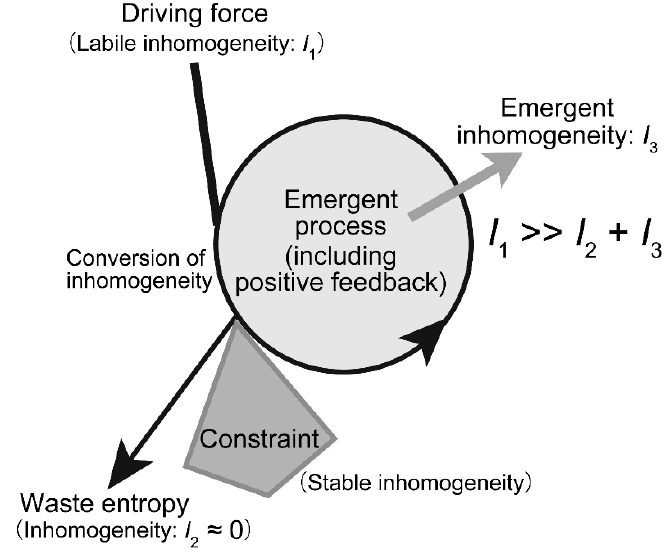
Figure 3. Schematic model of dynamic emergence. In dynamic emergence, a conflict between two inhomogeneities, one labile and another stable, produces another kind of inhomogeneity. At the same time, the process produces a large amount of entropy, which corresponds to the decrease in labile inhomogeneity. In most cases, the process includes positive feedback, which is the direct origin of the emergent inhomogeneity. The amount of emergent inhomogeneity is much smaller than the amount of consumed inhomogeneity.